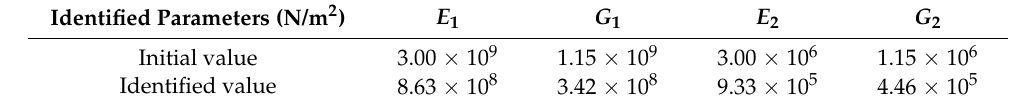
Table 6. Initial value of the identified parameters.